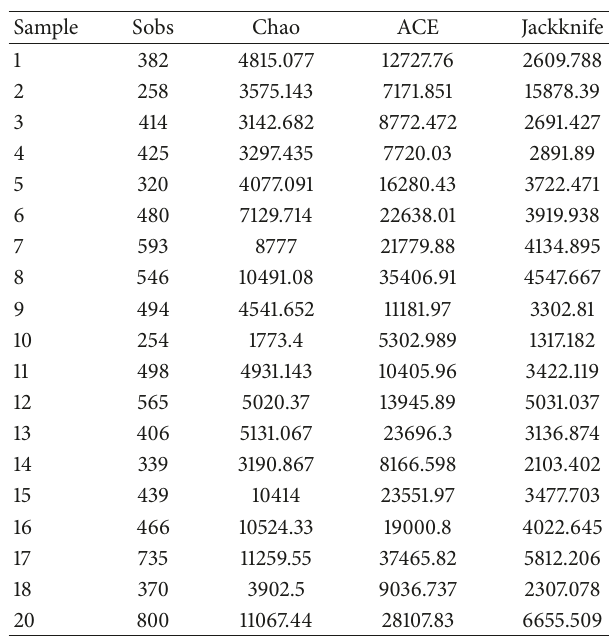
Table 2: Community richness indices: Sobs, Chao, ACE, and Jack-